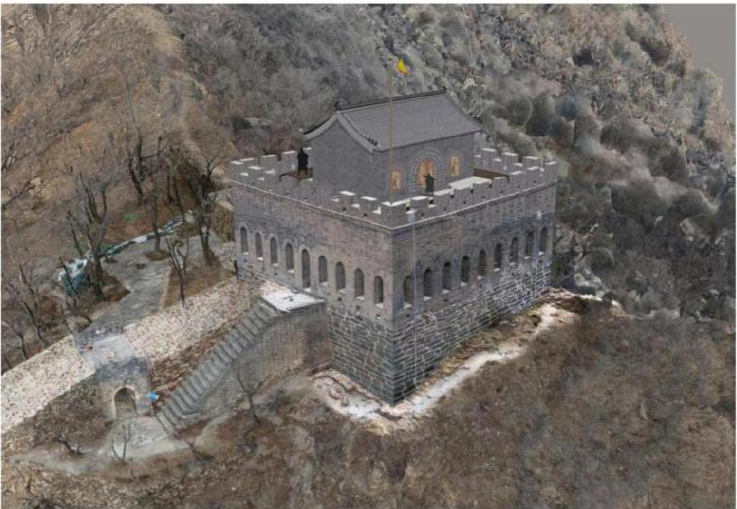
Figure 11. The results of virtual restoration for Nine-eyes